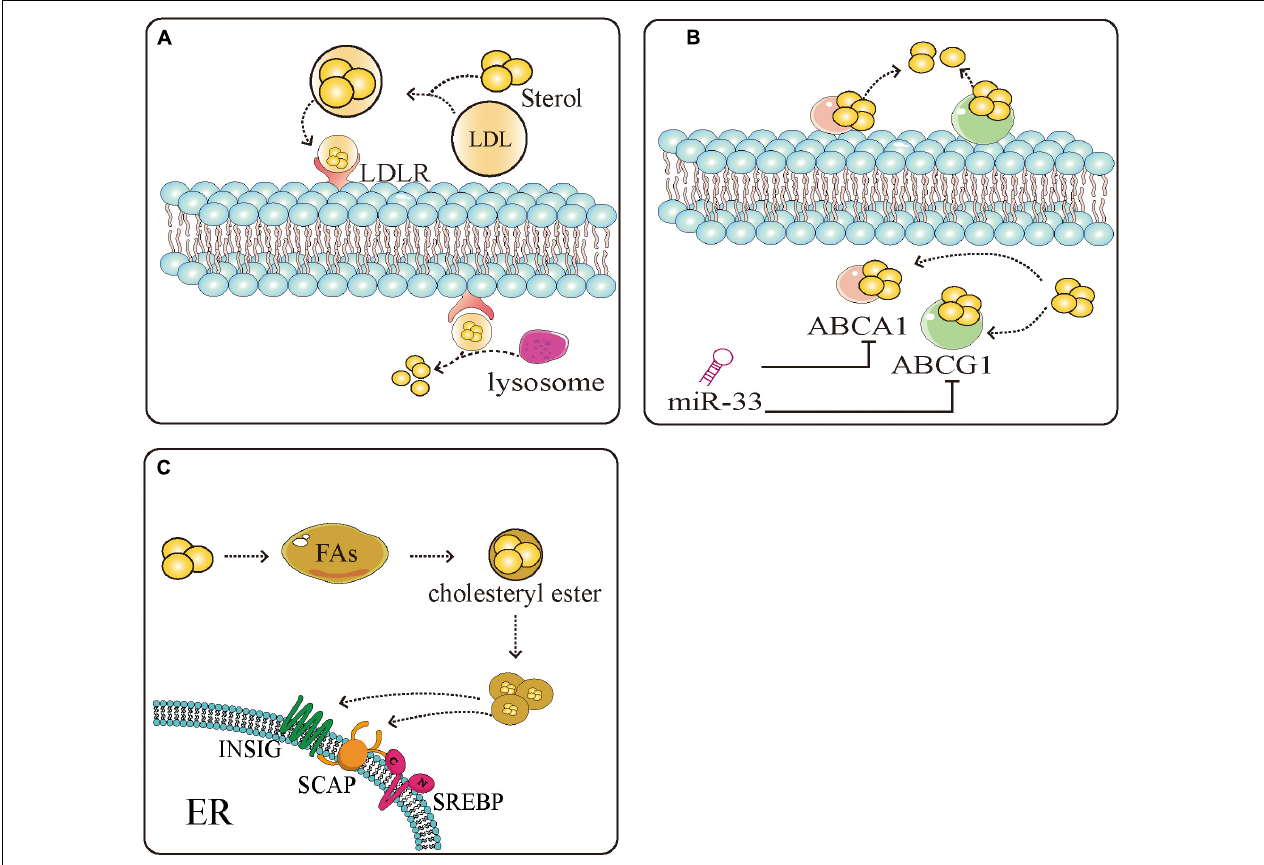
FIGURE 2 | Sterol regulatory element-binding protein (SREBPs) mediate the uptake, efflux, and storage of cholesterol. (A) Extracellular cholesterol is carried by low density lipoprotein (LDL) and binds to LDL receptors (LDLR) on the cell surface. After binding, cholesterol is transported to the cells and decomposed by the lysosome into intracellular cholesterol. (B) Intracellular cholesterol binds to the sterol transporter ATP binding cassette subfamily A member 1 (ABCA1)/ATP binding cassette subfamily G member 1 (ABCG1) and is transferred to the extracellular space to complete the uptake and discharge of cholesterol. miR-33 which is embedded in introns of, and co-transcribed with SREBPs can inhibit the expression of ABCA1 and ABCG1, thus inhibiting the reversal of cholesterol. (C) Excess cholesterol in the cells binds to SREBP-mediated fatty acids and esterifies them into cholesterol esters to avoid the negative regulation of cholesterol. These measures provide a large amount of energy and nutrients and protection for tumor cell